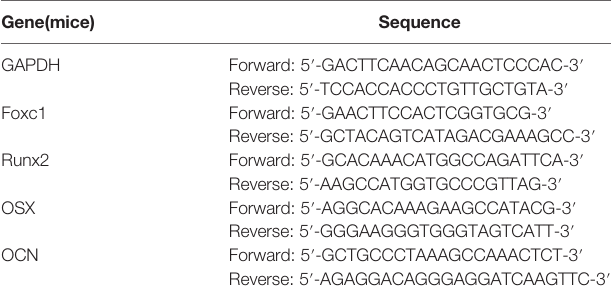
TABLE 2 | Primer sequences of expression plasmid. Primer Sequence (5 ′ to 3 ′ ) Foxc1-F (EcoRI)